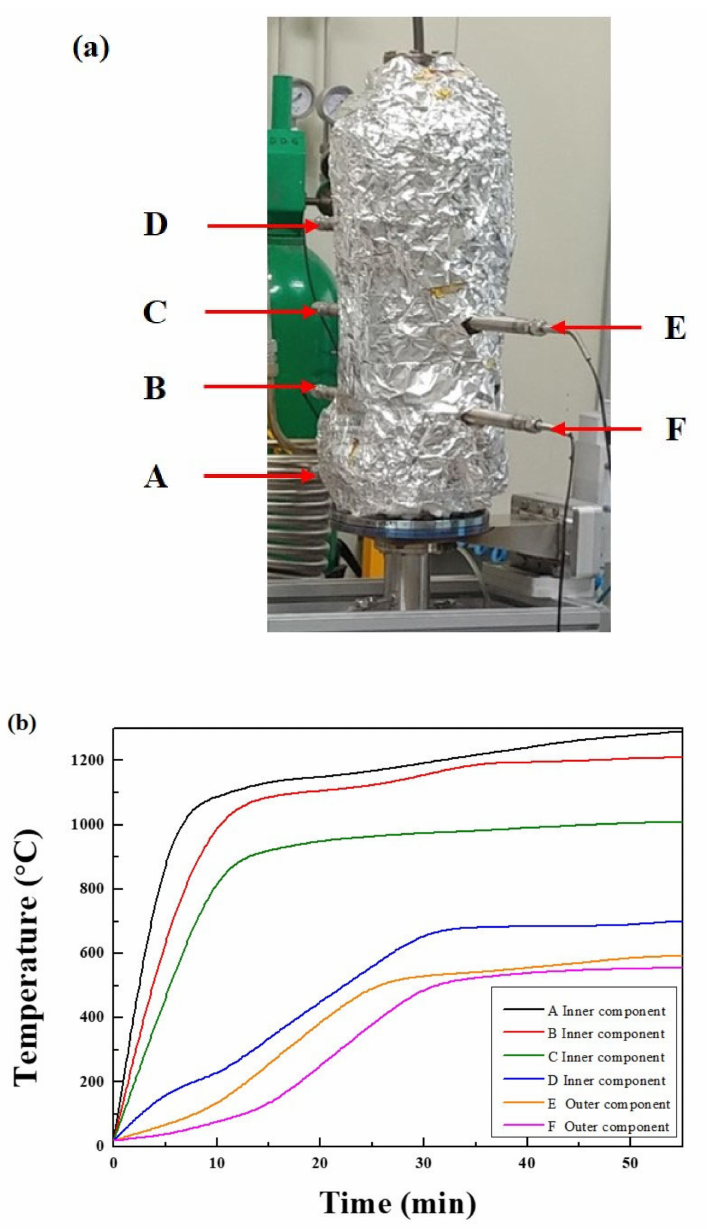
Figure 3. ( a ) Photograph of the insulated outer surface of the microwave plasma–catalytic reactor. ( b ) Temperature changes in the inner and outer components measured over 1 h using various